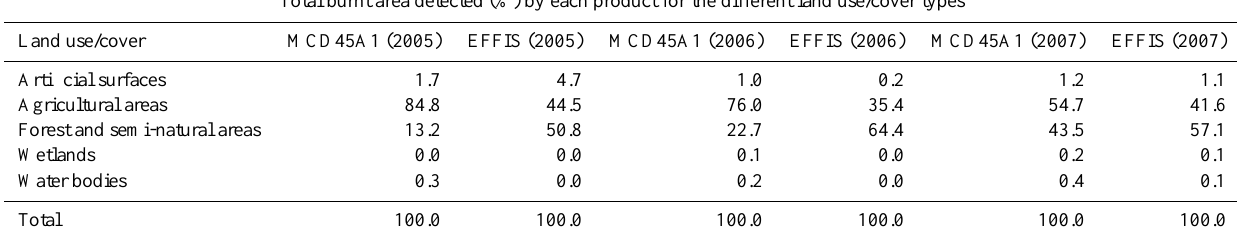
Table 2. Burnt area distribution (expressed as %) from both MCD45A1 & EFFIS operational products for the years 2005–2007 based on the CORINE 2000 land use/cover map.